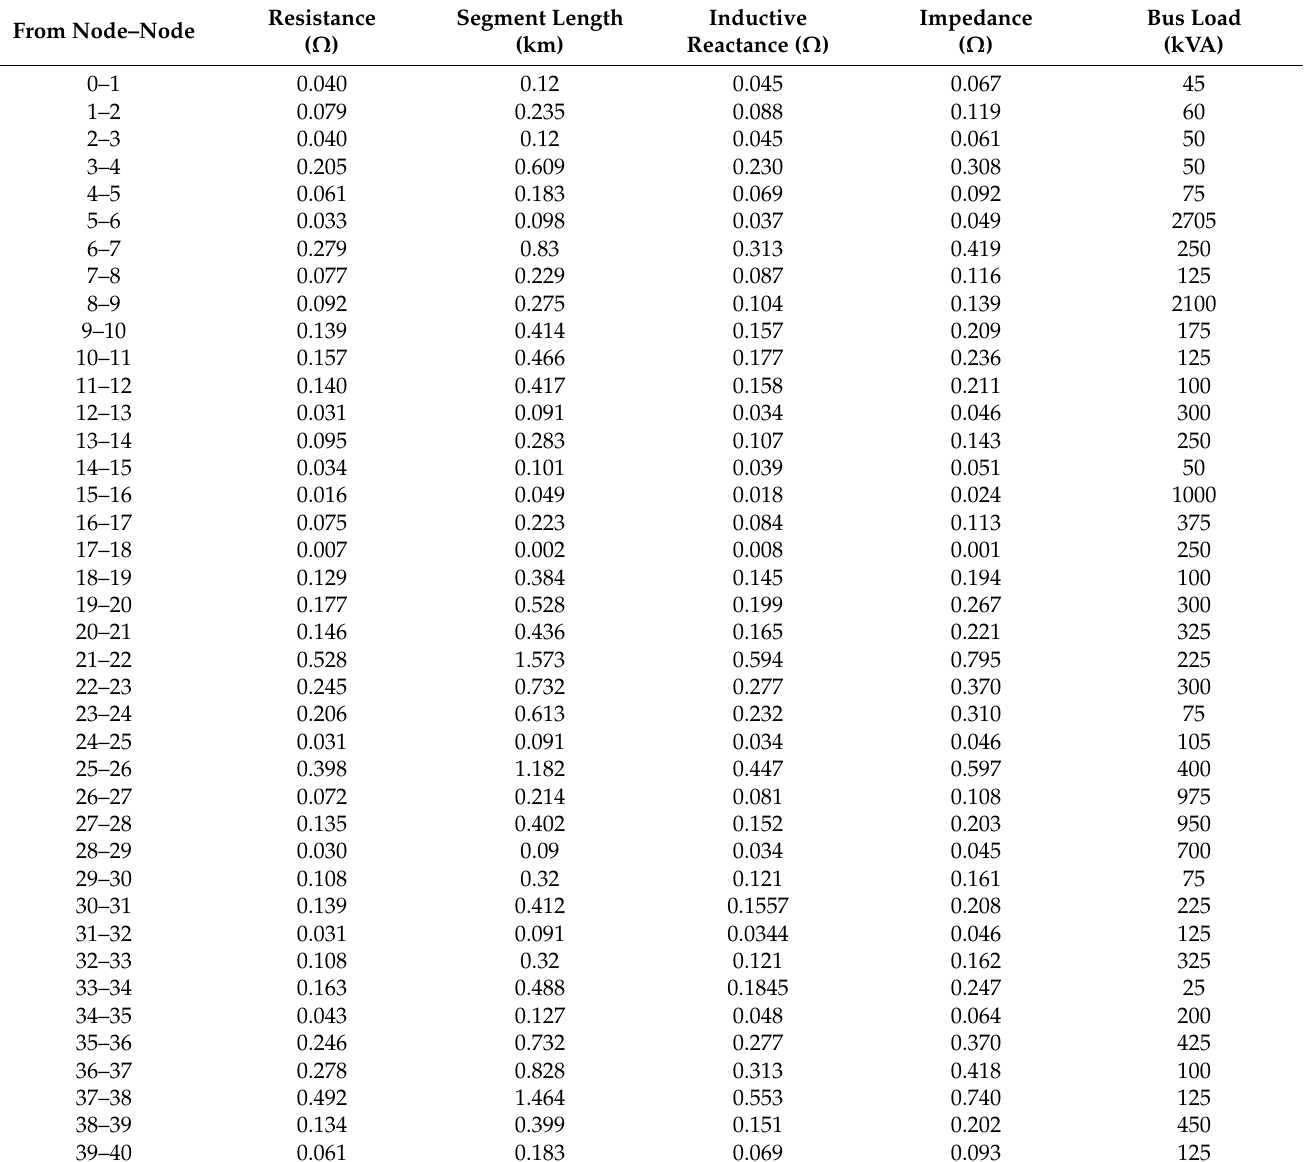
Table 1. Line parameters of actual distribution